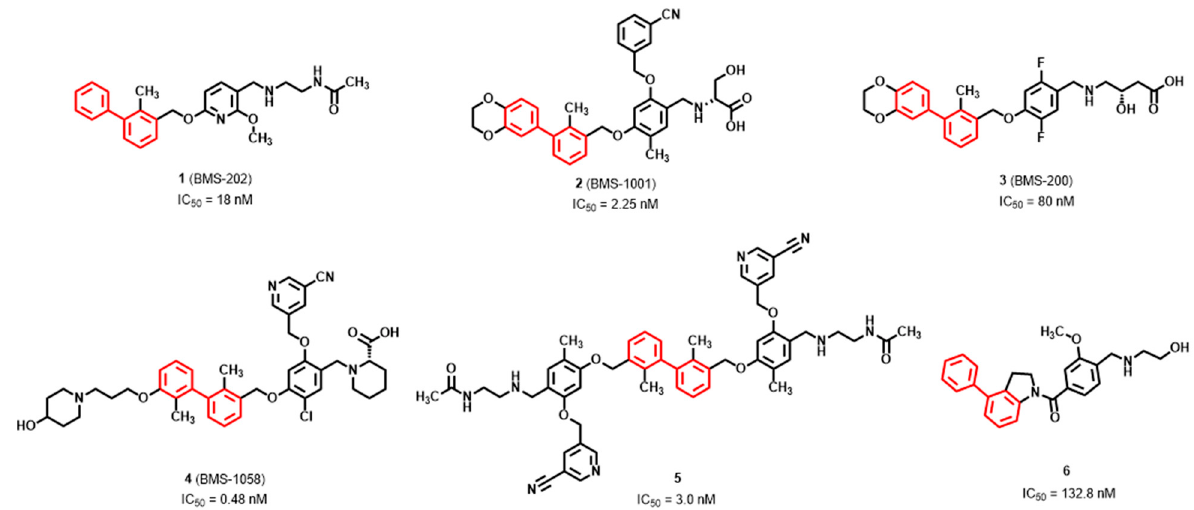
Figure 1. Structures of the reported compounds with binding PD-1/PD-L1 interaction. Biphenyl moiety is colored by red. IC 50 values are established by the HTRF binding assay.